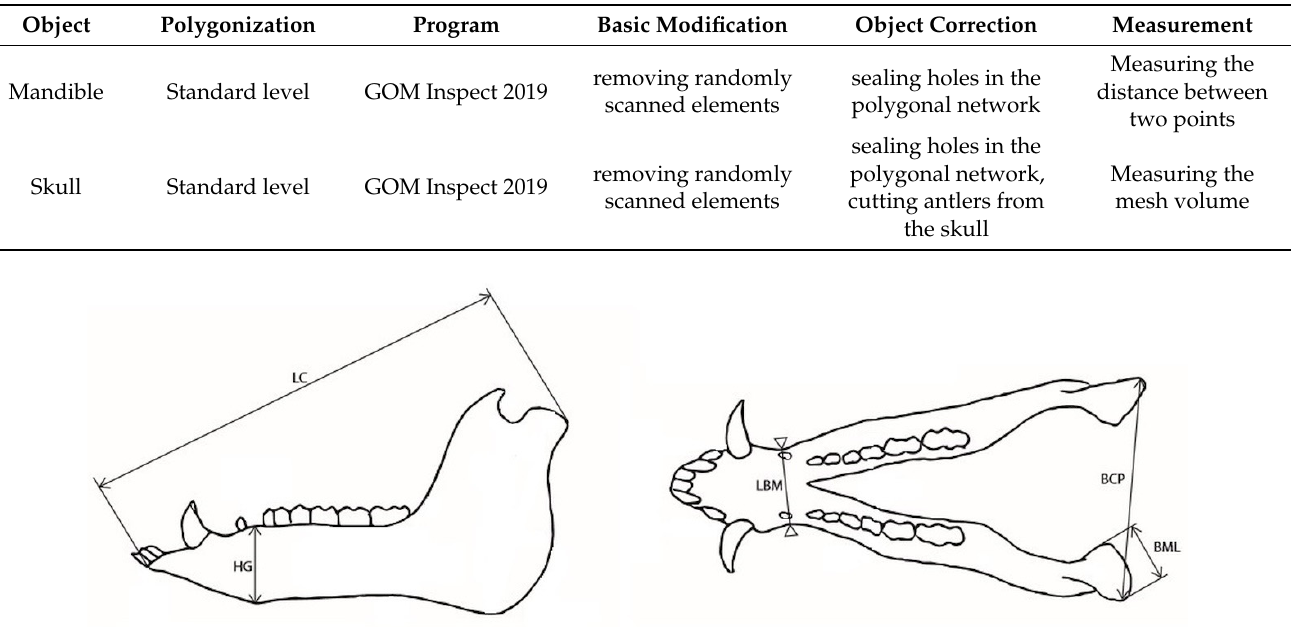
Table 2. Object postprocessing.